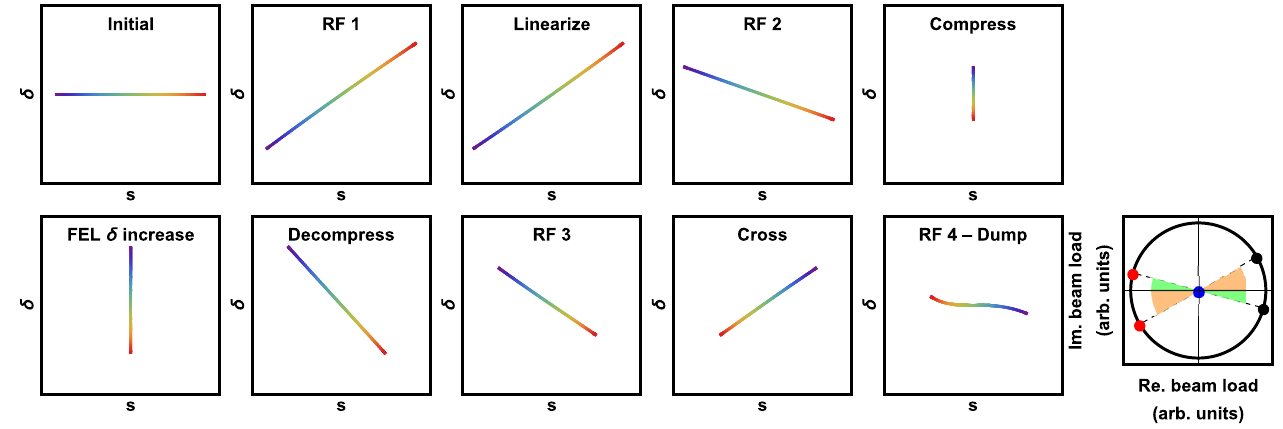
FIG. 18. Compressive longitudinal match with energy spread growth at the interaction point. Longitudinal phase spaces during acceleration (top) and during deceleration (bottom) with a parasitic crossing. rf beam load plot (bottom right) shows phase choices during acceleration (black), deceleration (red), and resultant (blue) with highlighted angles representing matching